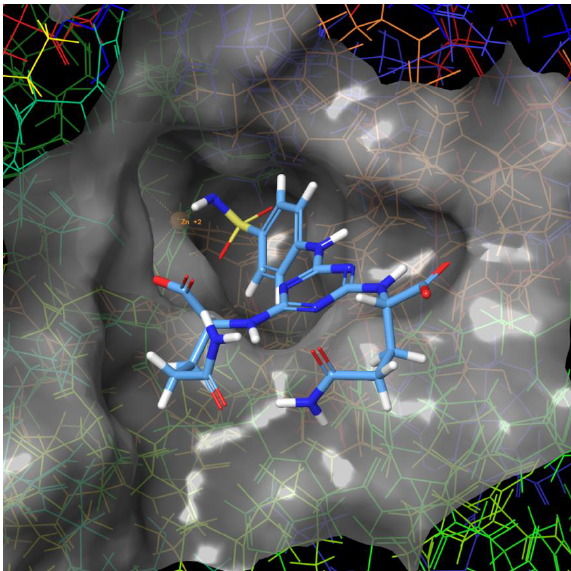
Figure 2 . Molecular surface of the binding site of hCA II with docked compound 7 (with Gln). Figure 2. Molecular surface of the binding site of hCA II with docked compound 7 (with